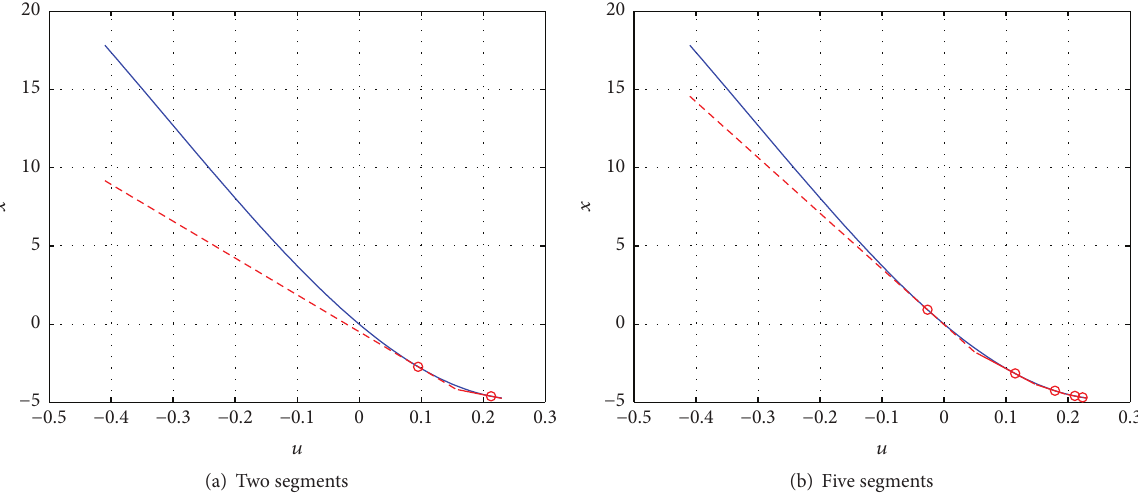
Figure 12: Linearization of the heat exchanger static